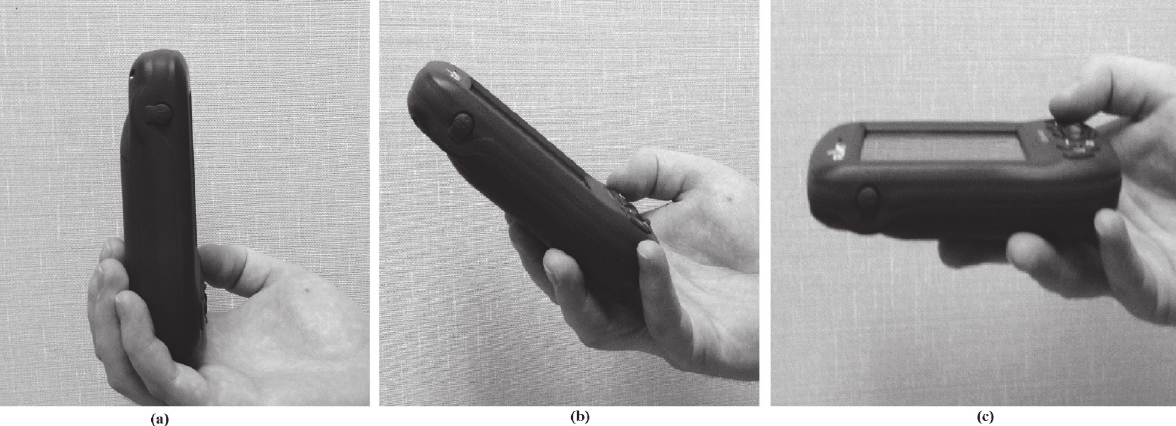
Fig 3. Examples of the three Flint GNSS receiver holding positions used in this study; (a) vertical, (b) angled, and (c) horizontal.